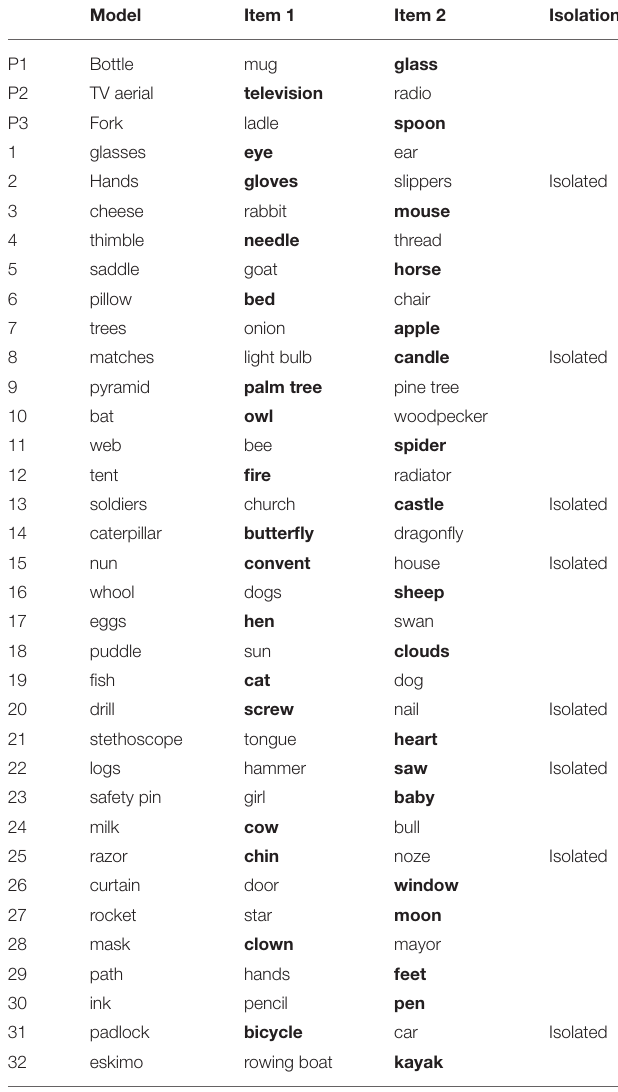
Eight board were chosen to be isolated by the addition of a yellow background to the pictures in Figure 1 . P1, P2, practice items; Bold items, correct matching responses and targets to be learned; Isolated, boards with a yellow background